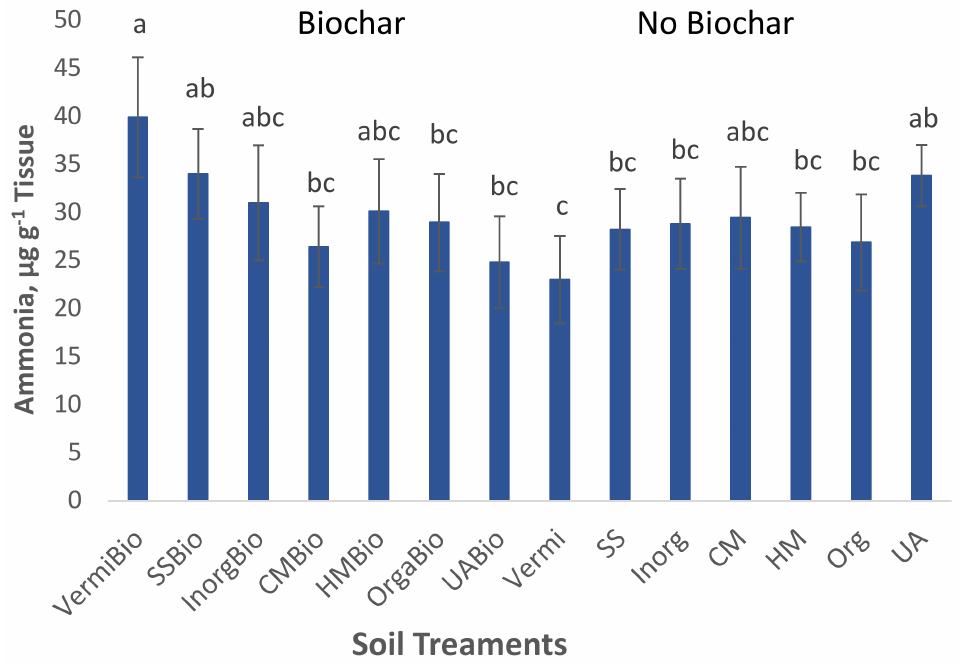
Figure 6. Concentrations of ammonia ± std. err in turnip plants grown under seven soil treatments not amended with biochar (vermicompost Vermi, sewage sludge SS, inorganic fertilizer Inorg, chicken manure, CM, horse manure HM, organic fertilizer Org, and unamended UA control), and seven soil treatments amended with biochar (VermiBio, SSBio, InorgBio, CMBio, HMBio, OrgBio, UABio), regardless of turnip varieties. Statistical analysis was carried out among 14 soil treatments using anal- ysis of variance (ANOVA). Standard errors having different letter(s) indicate significant differences ( p ≤ 0.05) using Duncan’s multiple range test for means